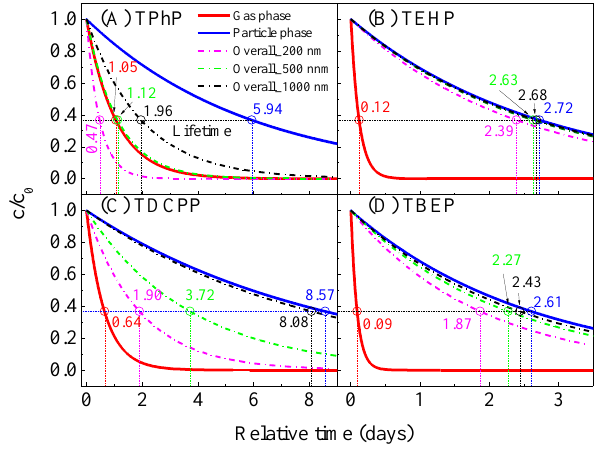
Figure 8. Influence of evaporation from particles of various diame- ter on the particle-phase loss rate of (a) TPhP, (b) TEHP, (c) TDCPP and (d)